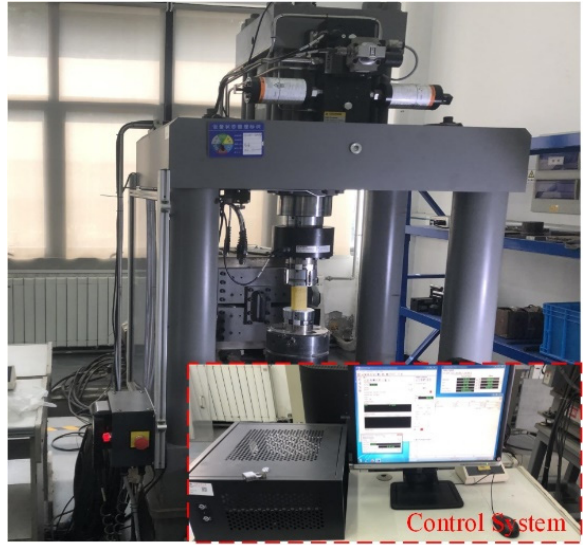
Figure 5. MTS816 experimental system.